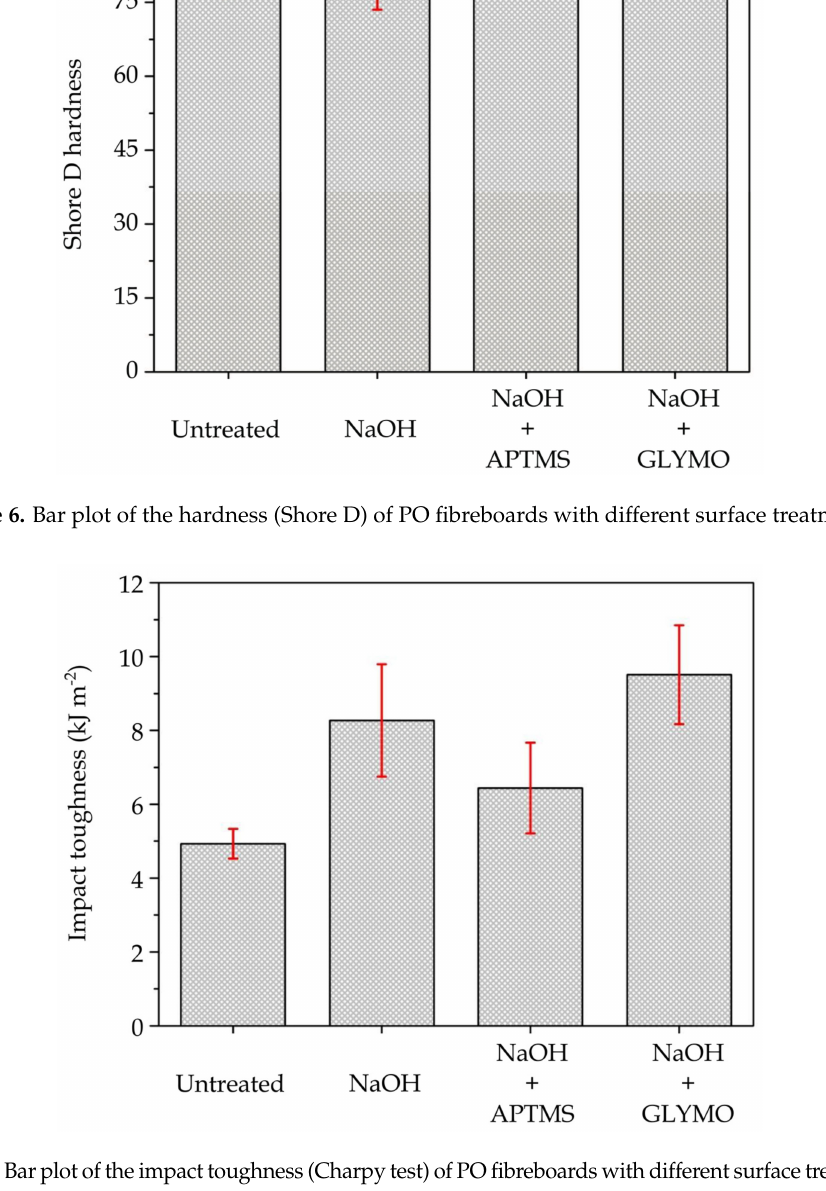
Figure 7. Bar plot of the impact toughness (Charpy test) of PO fibreboards with different surface